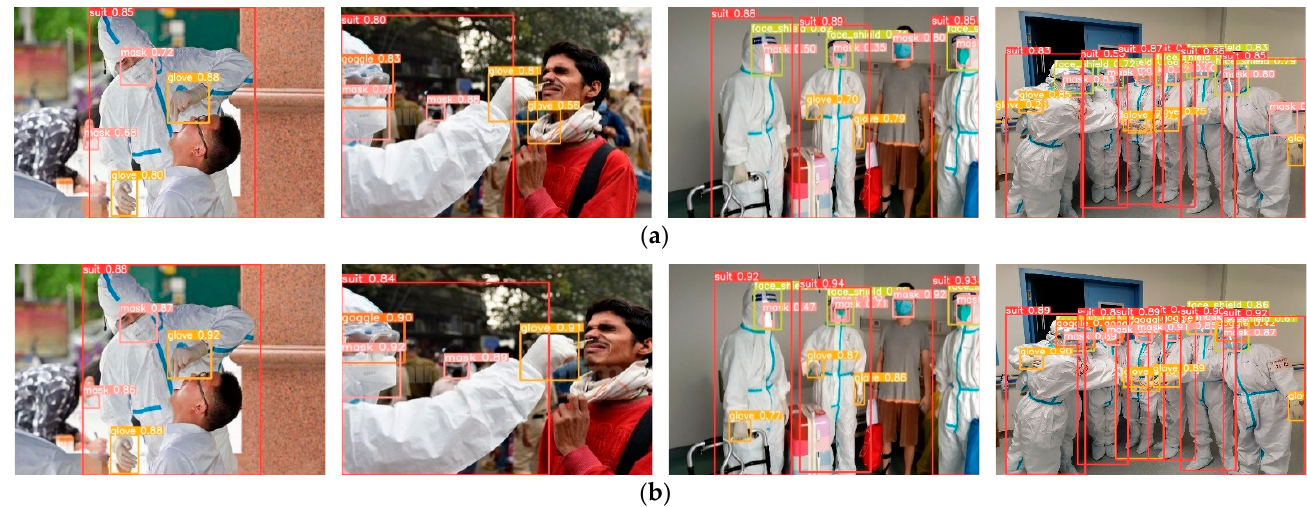
Figure 12. Visual comparison between YOLOv5s and ME ‐ YOLO. ( a ) YOLOv5s; ( b ) ME ‐ YOLO.